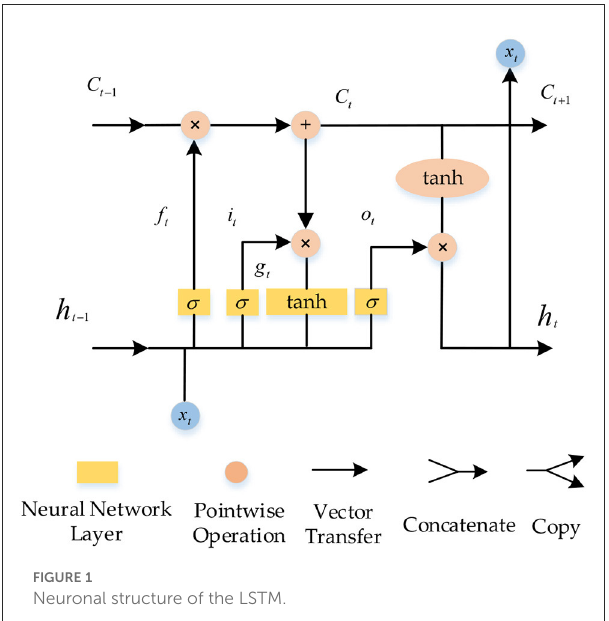
FIGURE1 Neuronal structure of the